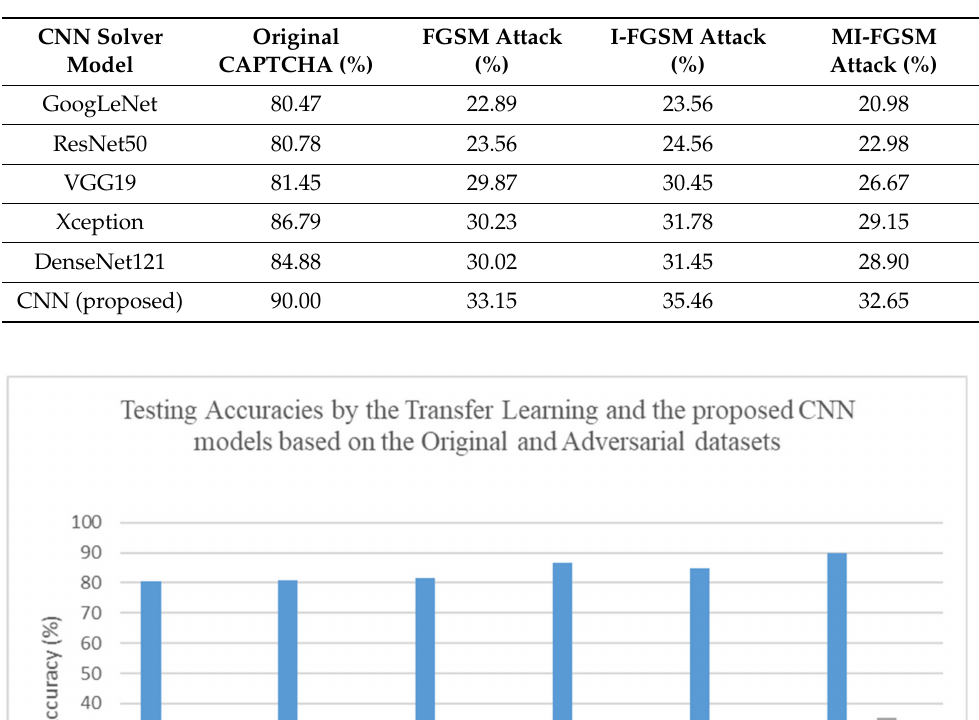
Table 4. Comparison accuracy results between the transfer learning CNN models and the proposed CNN solver model based on the original text-based CAPTCHA, FGSM attack, I-FGSM attack, and MI-FGSM attack testing datasets.